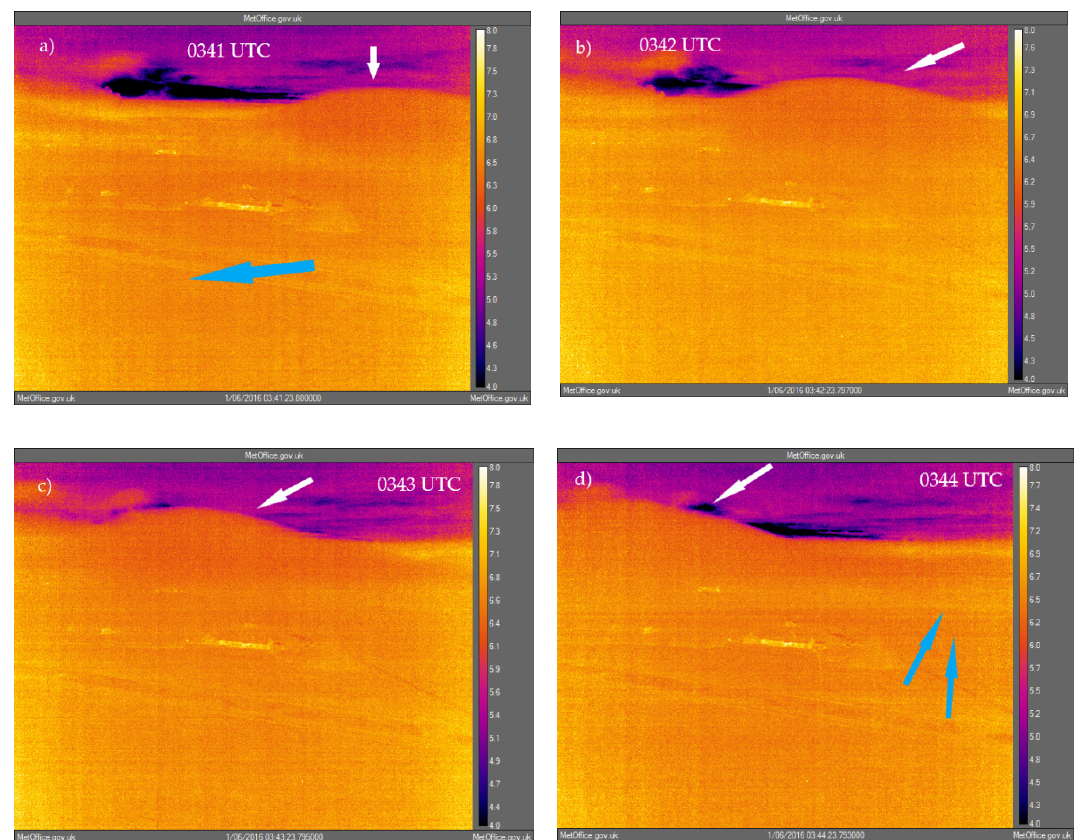
Figure 5. Illustrating the passage of an isolated gravity wave (white arrows) occurring over the Cardington site at, ( a ) 0341 UTC, ( b ) 0342 UTC, ( c ) 0343 UTC and ( d ) 0344 UTC. The blue arrow in panel ( a ) depicts the approximate down-valley direction. The blue arrows in panel ( d ) indicate the approximate locations of, temperature, humidity, wind, and visibility measurements.